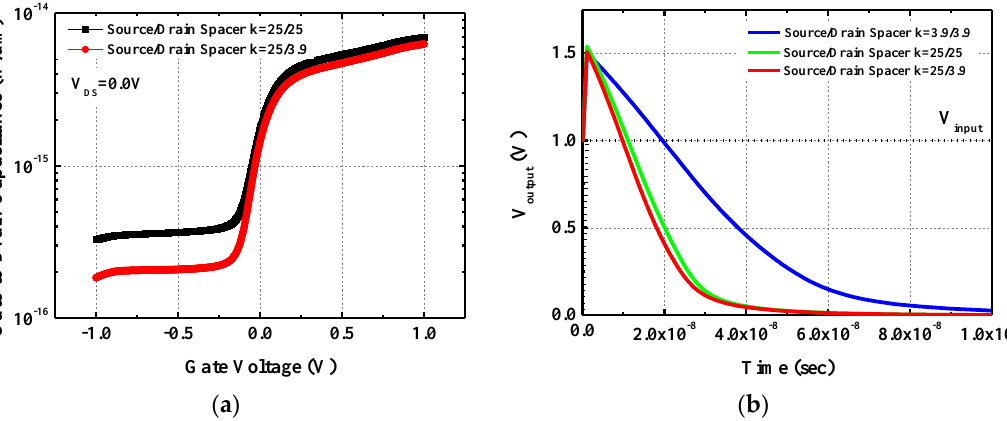
Figure 7. ( a ) Gate-to-drain capacitance-voltage characteristics at V DS = 0.0 V with symmetric high- κ